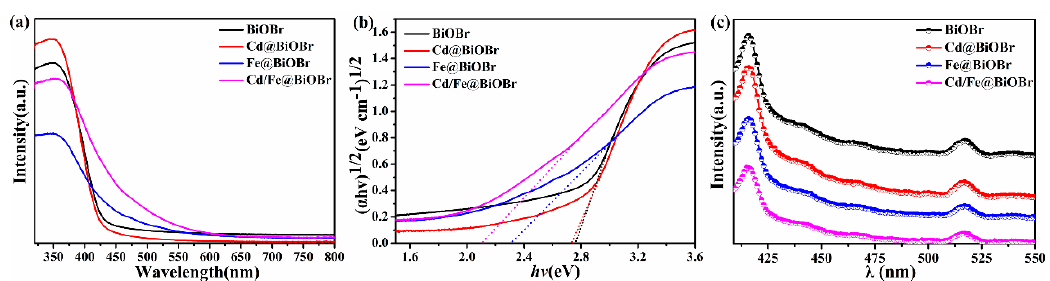
Figure 6. UV-vis spectra ( a ) and ( α hv ) 1/2 vs. hv curves of photocatalysts ( b ); photoluminescence (PL) spectra ( c ). Table 1. Absorption edges and band gaps for photocatalysts.